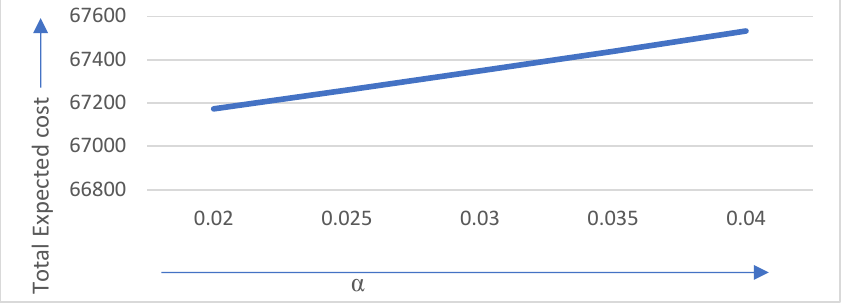
Figure 3. Effect of rate of change of human error on total cost